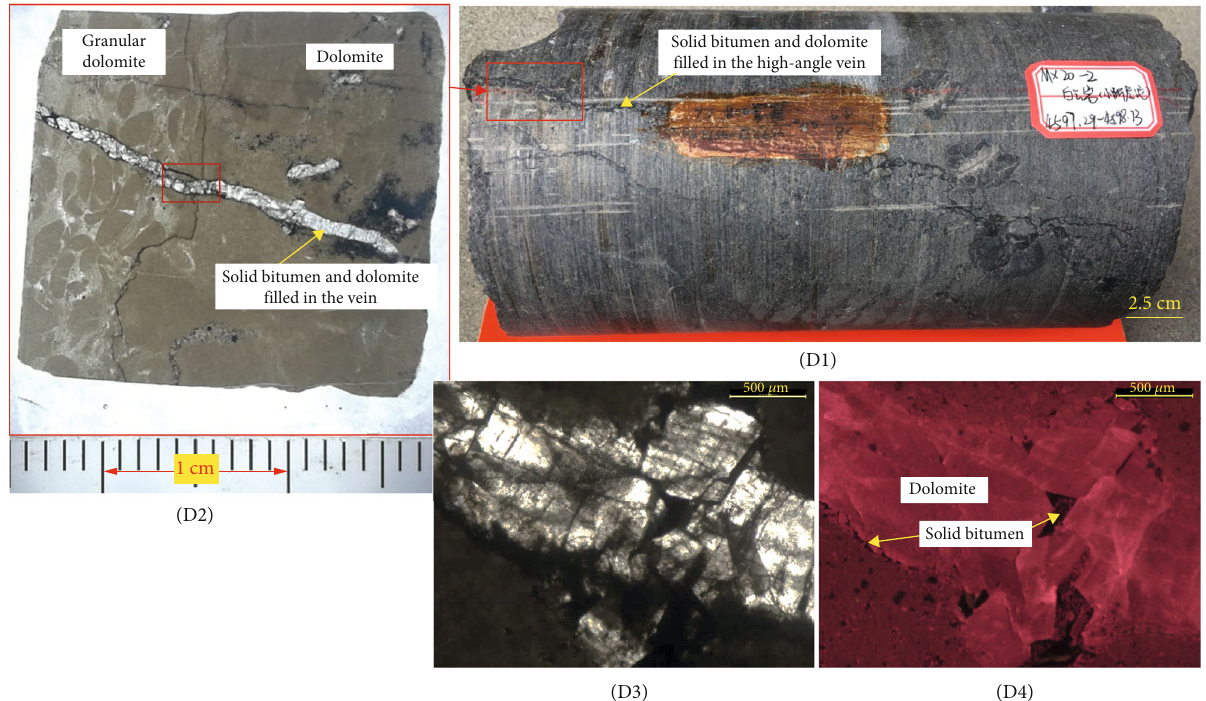
Figure 4: The Longwangmiao Formation, Well MX20 (4597.29-4598.73m,). Cores and thin sections with associated petrological observations. (D1) core sample, high-angle cracks in muddy microcrystalline dolomite fi lled with solid asphalt+dolomite veins. (D2) Thin section showing partially/fully fi lled cracks and dissolution holes in asphalt. (D3) (-) and (D4) (CL) Pore fi ll types identi fi ed in cracks and dissolution pores included the following: solid asphalt → dolomite. (-): single-polarized light; CL: cathodoluminescence; UV: fl